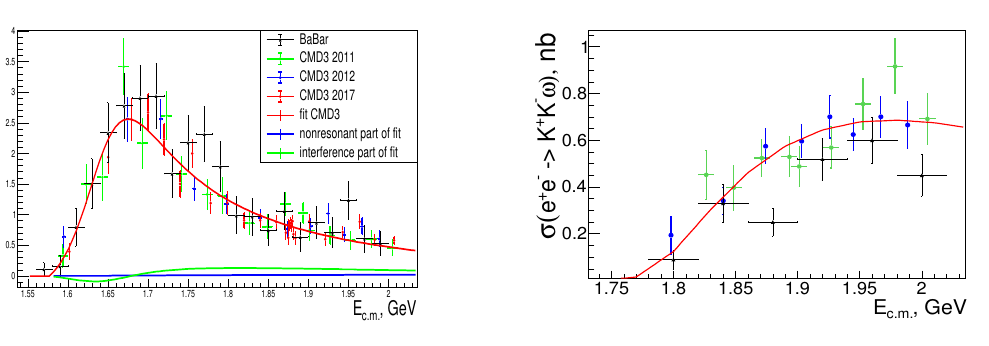
Figure 4. Cross section of the process e + e − → K + K − ω (782) with the BaBar data pre- sented by black triangles, CMD-3 - green and blue (2017). The fit - approximation of CMD-3